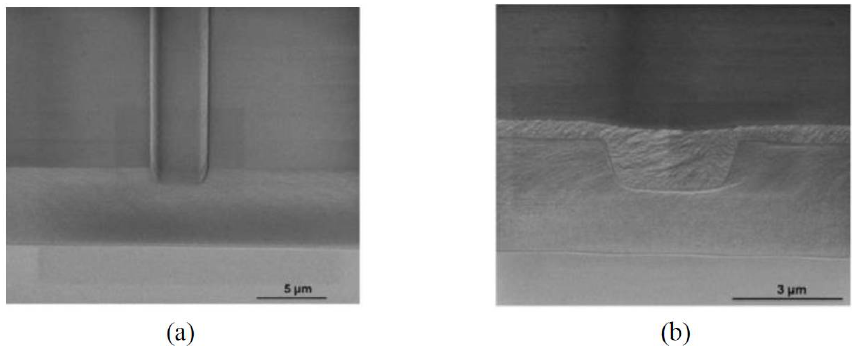
Figure 4. The SEM pictures of ( a ) the imprinted low index layer and ( b ) the waveguide cross section after spin-coating the high index layer [35].